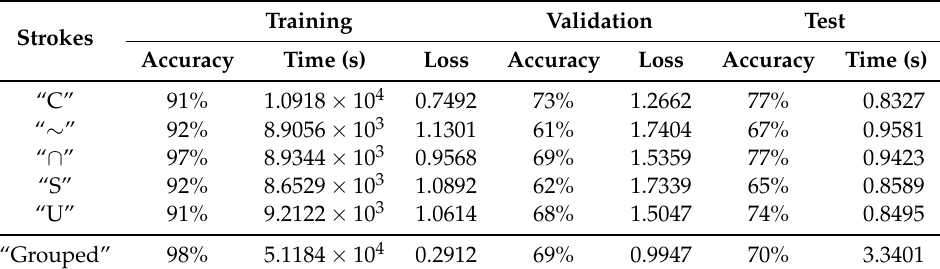
Table 7. Rectified Simple Grapheme - ResNet-18 (epoch =